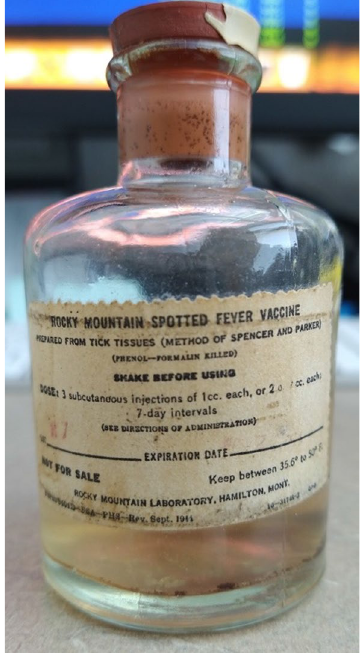
Figure 1. The bottle of Rocky Mountain Spotted Fever Vaccine made in 1944.